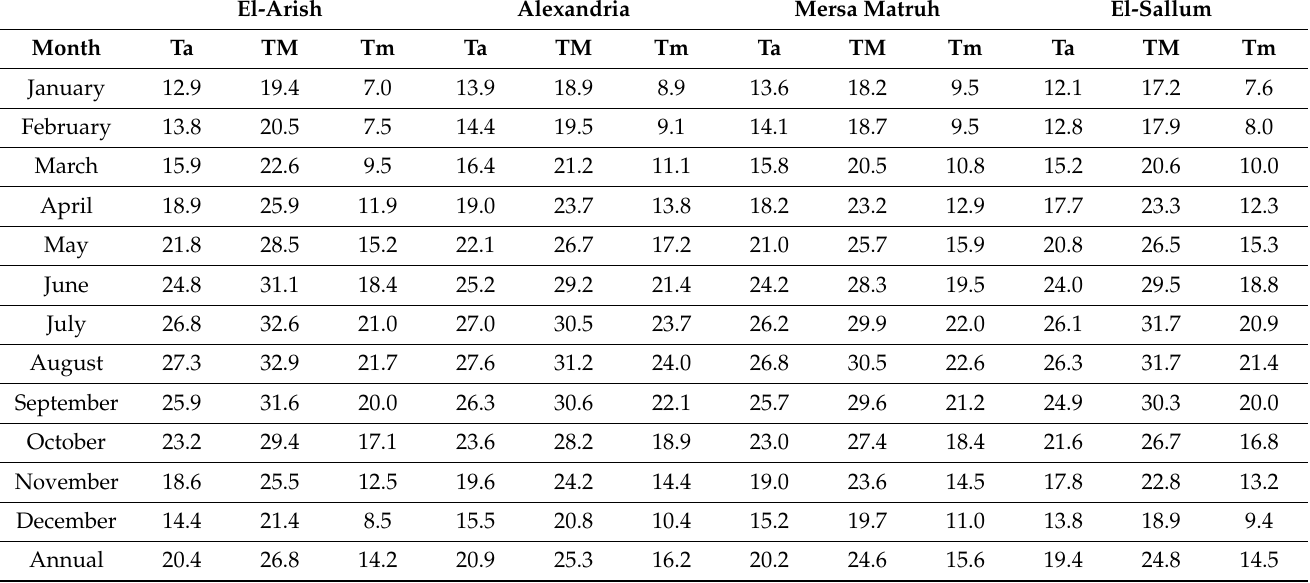
Table 3. Monthly and annual air temperatures from 1991 to 2020 for the weather stations of El-Arish, Alexandria, Mersa Matruh, and